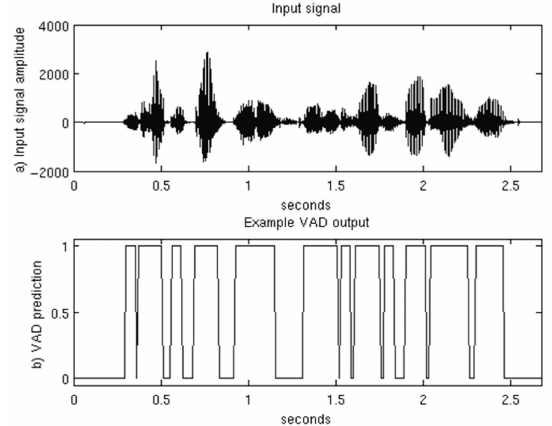
Figure 1. Voice Activity Detector (VAD) applied on voice